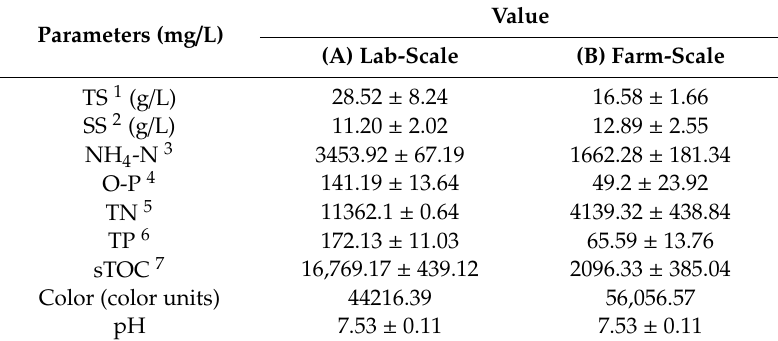
Table 1. Characteristics of swine